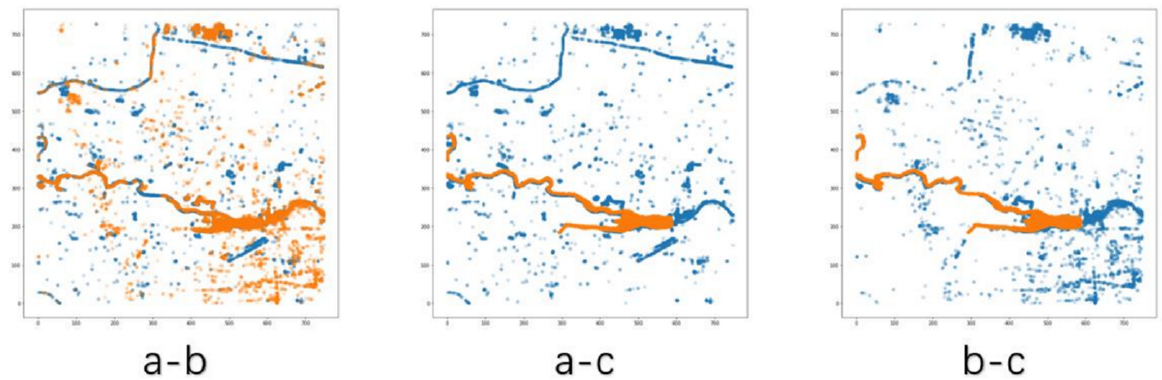
Figure 9. Overlay of raster data map frames ( a - b . GLC_FCS30-FROM_GLC; a - c . GLC_FCS30- CNLUCC; b - c . FROM_GLC-CNLUCC). Table 6. Results of water body.